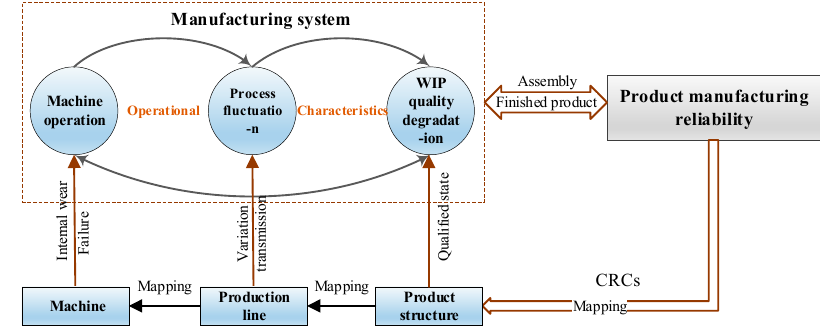
Figure 3. Multilayered model of operational characteristics.